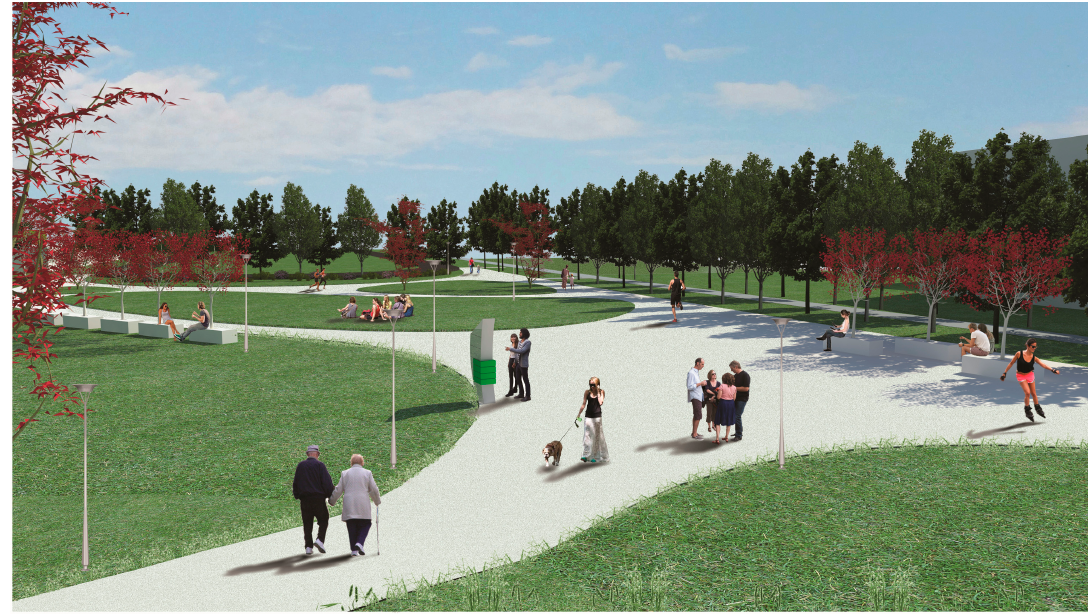
Figure 9. View of the central part of the park.